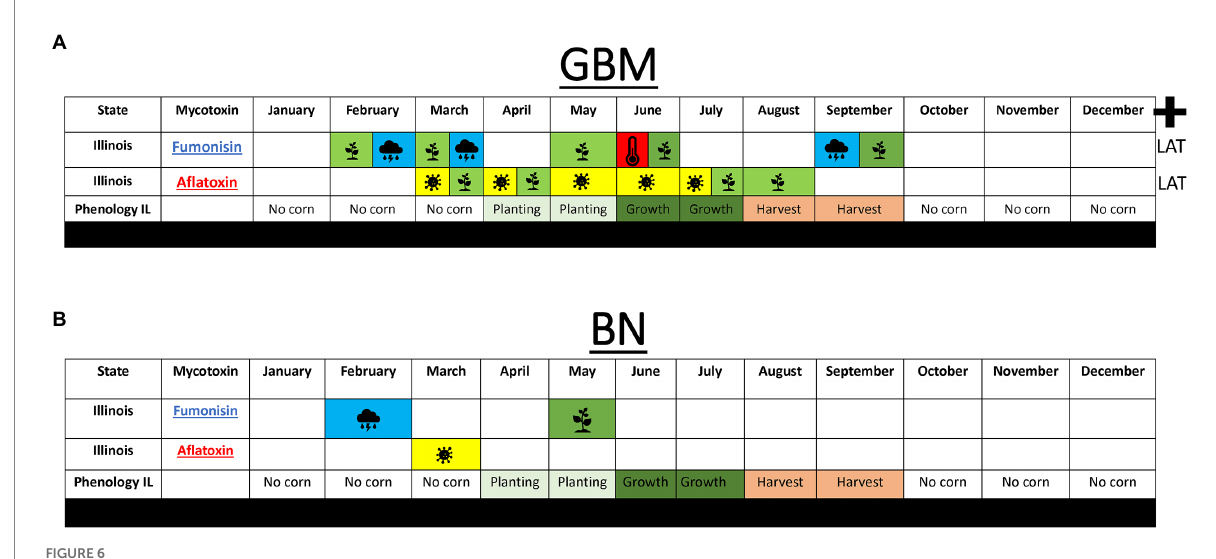
FIGURE 6 Summary of model analyses performed to predict fumonisin and AFL in Illinois. (A) Top 10 weather features for GBM using growth per month for AFL and (B) , BN using growth per months for AFL. Blue shade with rain cloud depicts average monthly precipitation, red shade with thermometer depicts average temperature, yellow shade with fungal head depicts average monthly fungal growth. Plus-sign indicates latitude was a significant feature in the model. Average phenology of cropping in Illinois is depicted as no-corn in the field (no color), planting time (light green), vegetative growth (dark green), harvest time (salmon) taken from Usual Planting and Harvesting Dates Agricultural Statistics Board from USDA National Agriculture Statistic Services